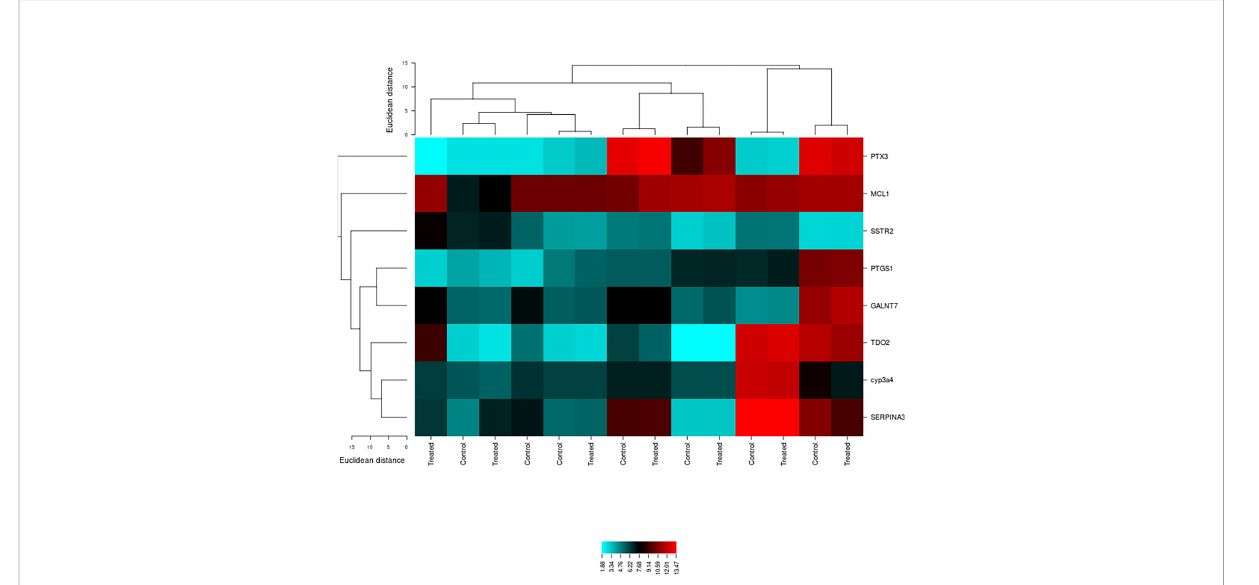
FIGURE 3 Cluster analysis of type 2 diabetes-associated differentially expressed signature genes using the CIMminer tool. Blue indicates a large distance, while red represents a small distance. Lines show the cluster boundaries in the level of the